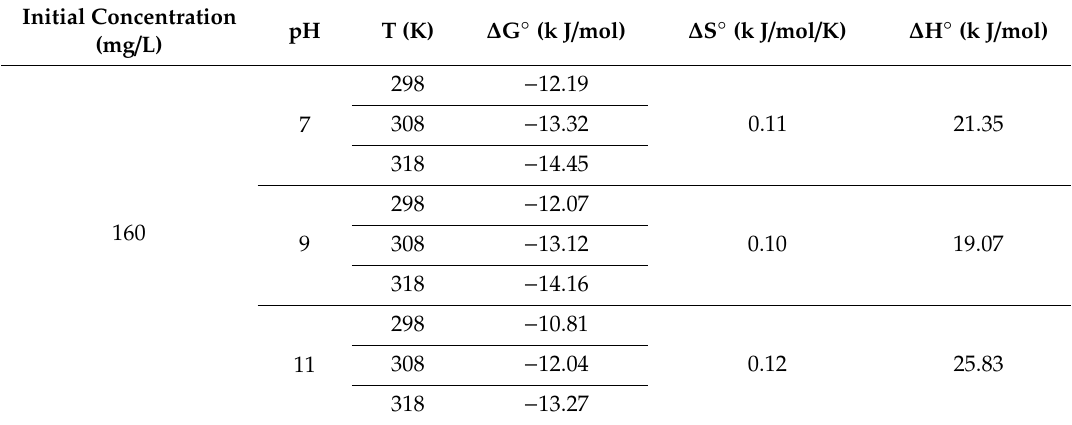
Table 2. Thermodynamic parameters for PO 4 − 3 sorption by nSD-GU bio-sorbent at di ff erent solution pH values (7–11) and 160 mg L − 1 initial PO 4 − 3